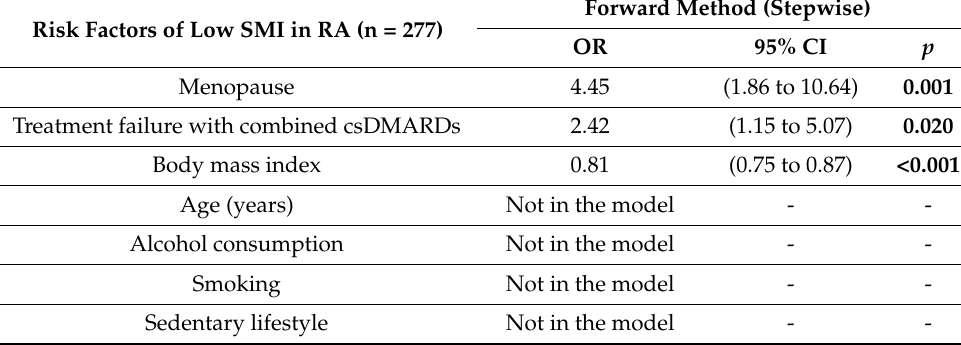
Table 3. Multivariable Logistic Regression analysis evaluating factors associated with muscle wasting in women with Rheumatoid